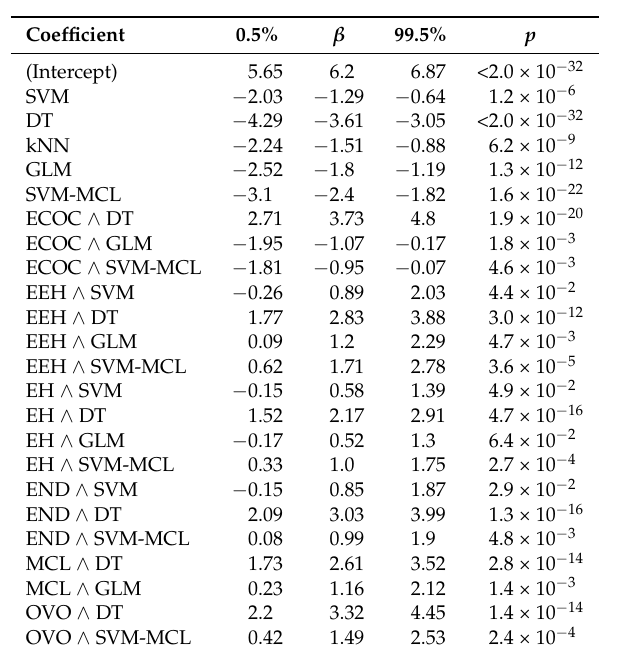
Table 6. Estimated logistic regression coefficients with p < 0.1 for the binary problem induced by the topmost dichotomy of